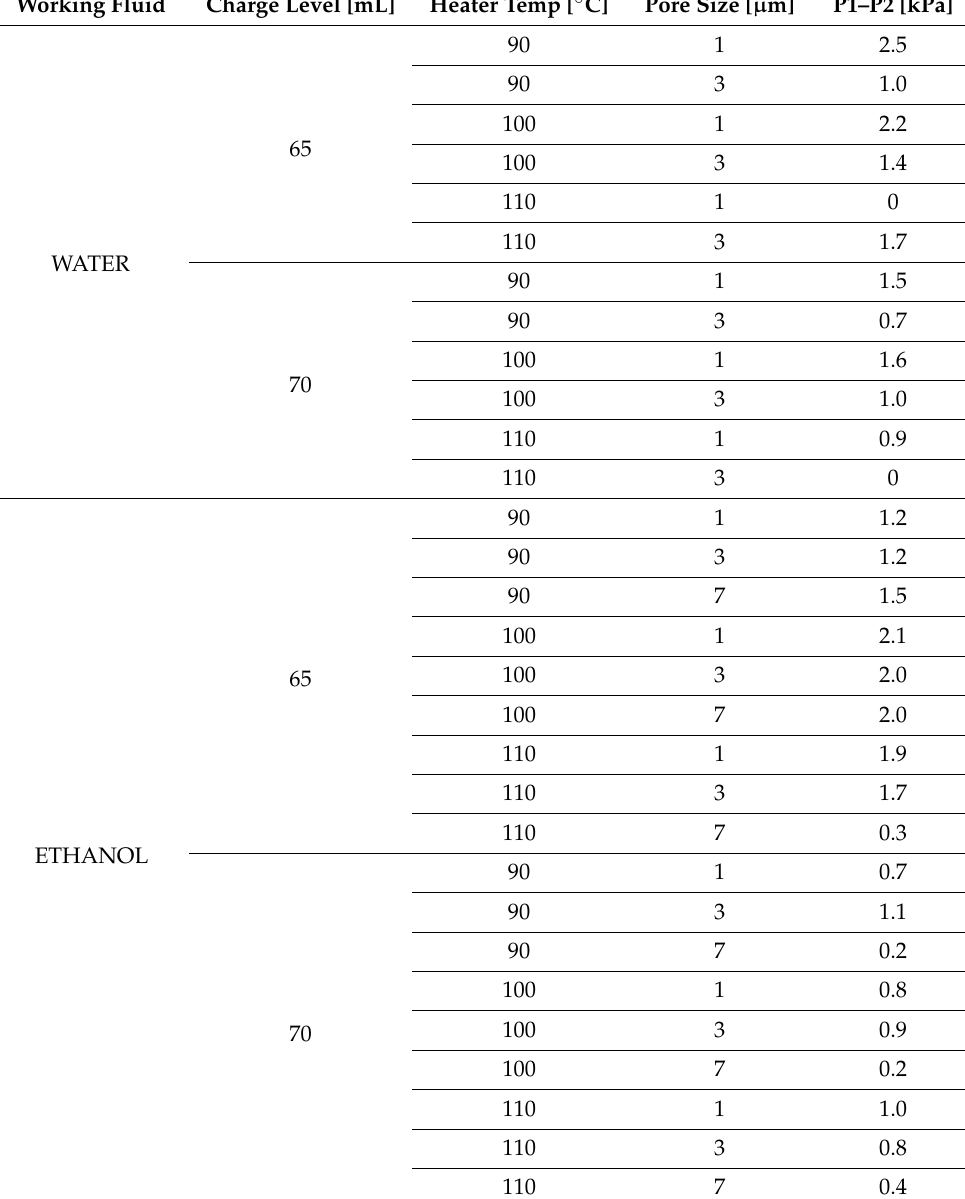
Table 4. Range of investigated